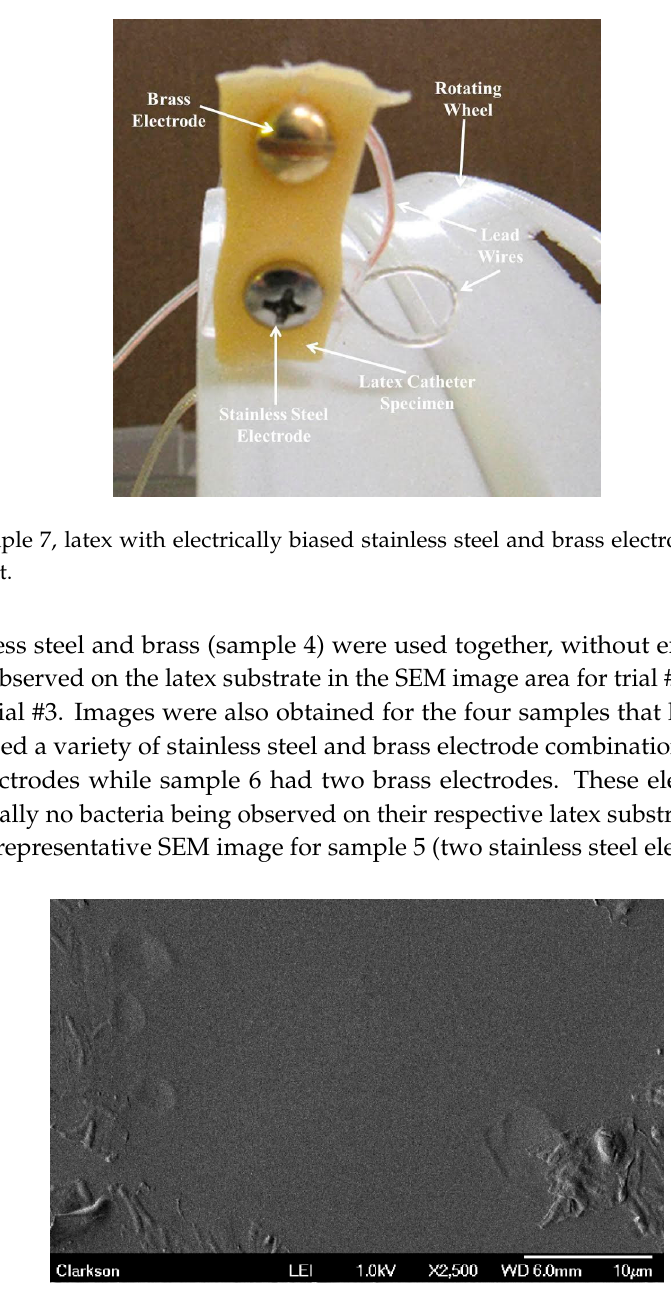
Figure 5. The SEM image (at 2500 ˆ ) of the aged Sample 5 (stainless steel and stainless steel with added voltage) is essentially free of rod shaped bacteria. The rough edges show aged portions of the